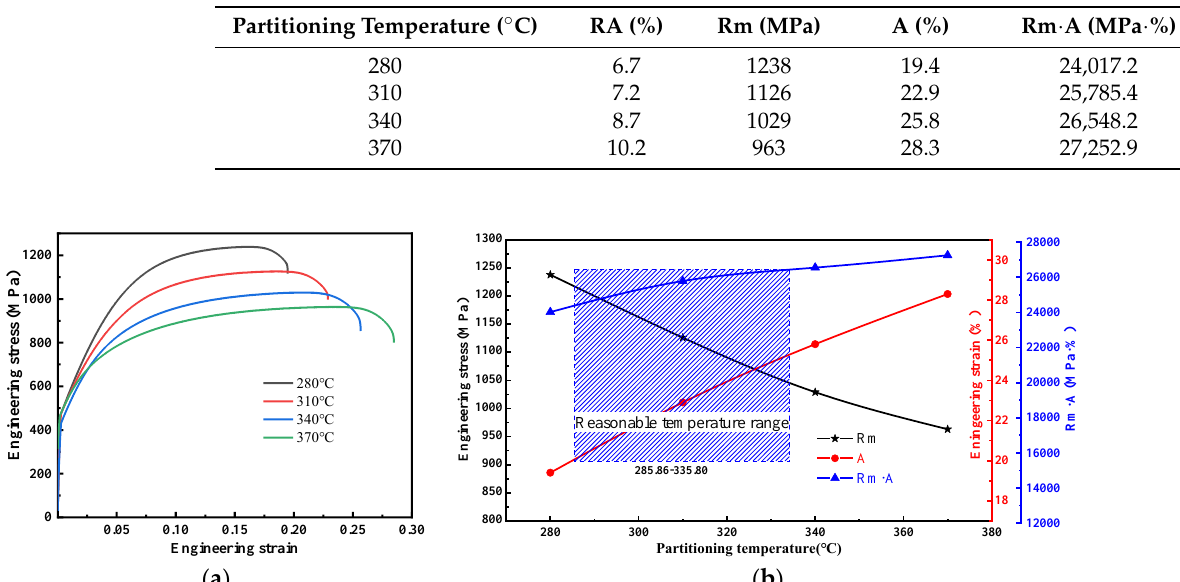
Table 1. Mechanical properties of steel treated at different partitioning temperatures.